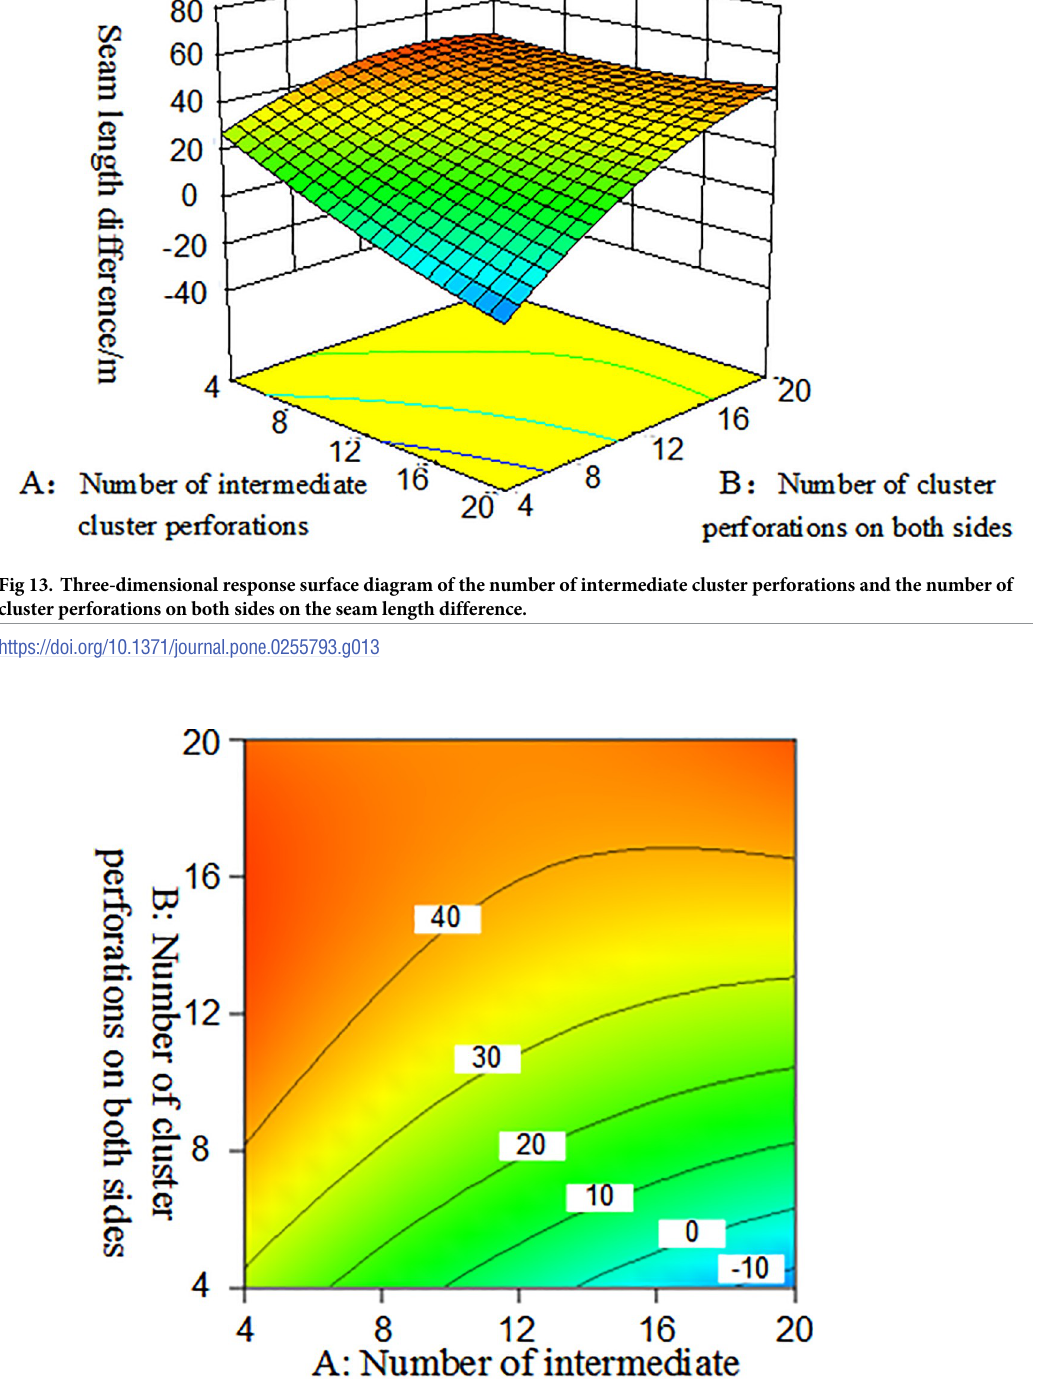
PLOS ONE | https://doi.org/10.1371/journal.pone.0255793 August 18,